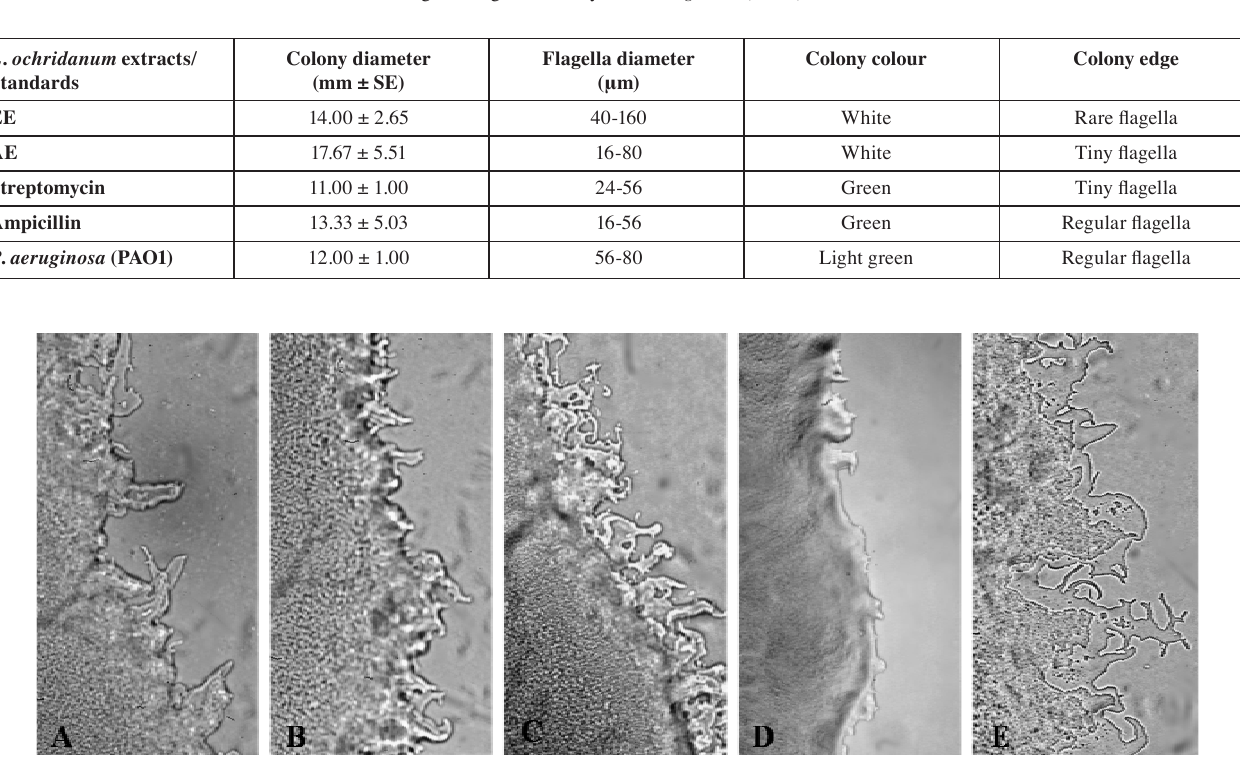
Fig. 1: Light microscopy of colony edges of P . aeruginosa in twitching motility, grown in the presence or absence of L . ochridanum extracts and commercial antibiotics. The colonies from the bacteria grown with extracts in concentration of 0.5 MIC ( A-B ). The colony with EE was with moderately reduced protrusions ( A ); In the presence of AE colony formed almost regular protrusions ( B ); P . aeruginosa colony in the presence of streptomycin (0.5 MIC) with reduced protrusion ( C ); P . aeruginosa colony in the presence of ampicillin with regularly formed protrusions ( D ); P. aeruginosa produced a flat, widely spread, irregularly shaped colony in the absence of extracts and commercial antibiotics ( E ); Magnification: ( A-D ) ×